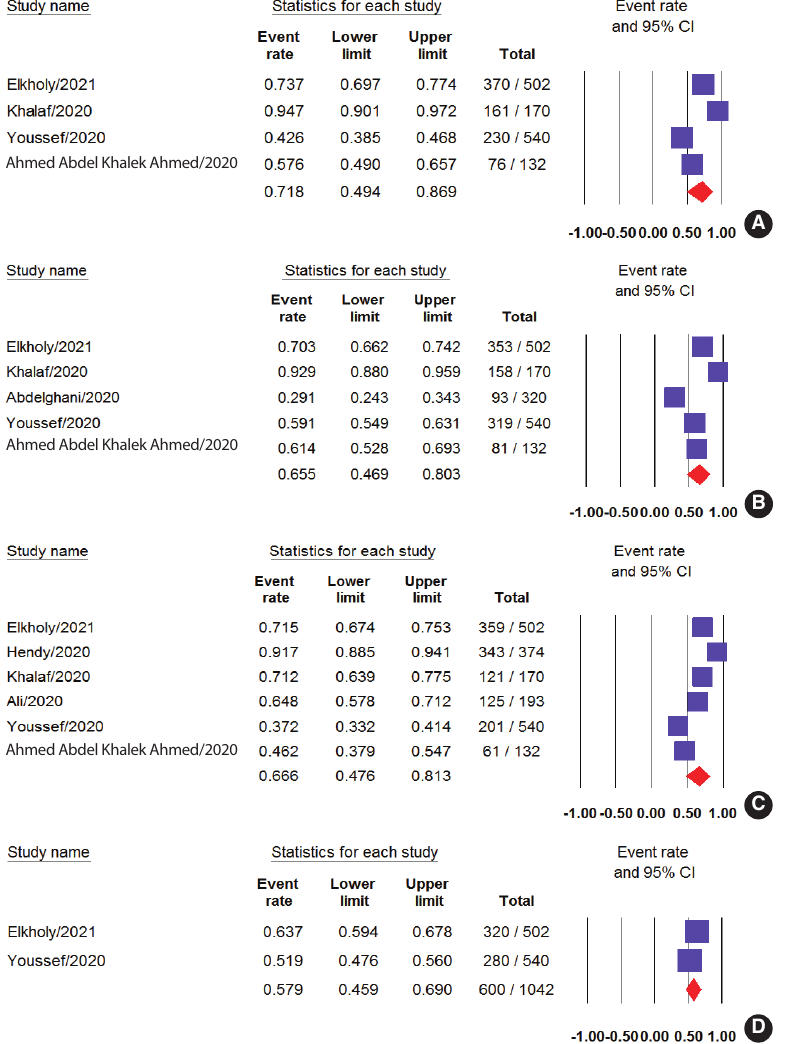
Figure 3. The prevalence of (A) total anxiety, (B) total depression, (C) total stress, and (D) total insomnia represented by the event rate and the corresponding 95% confidence interval